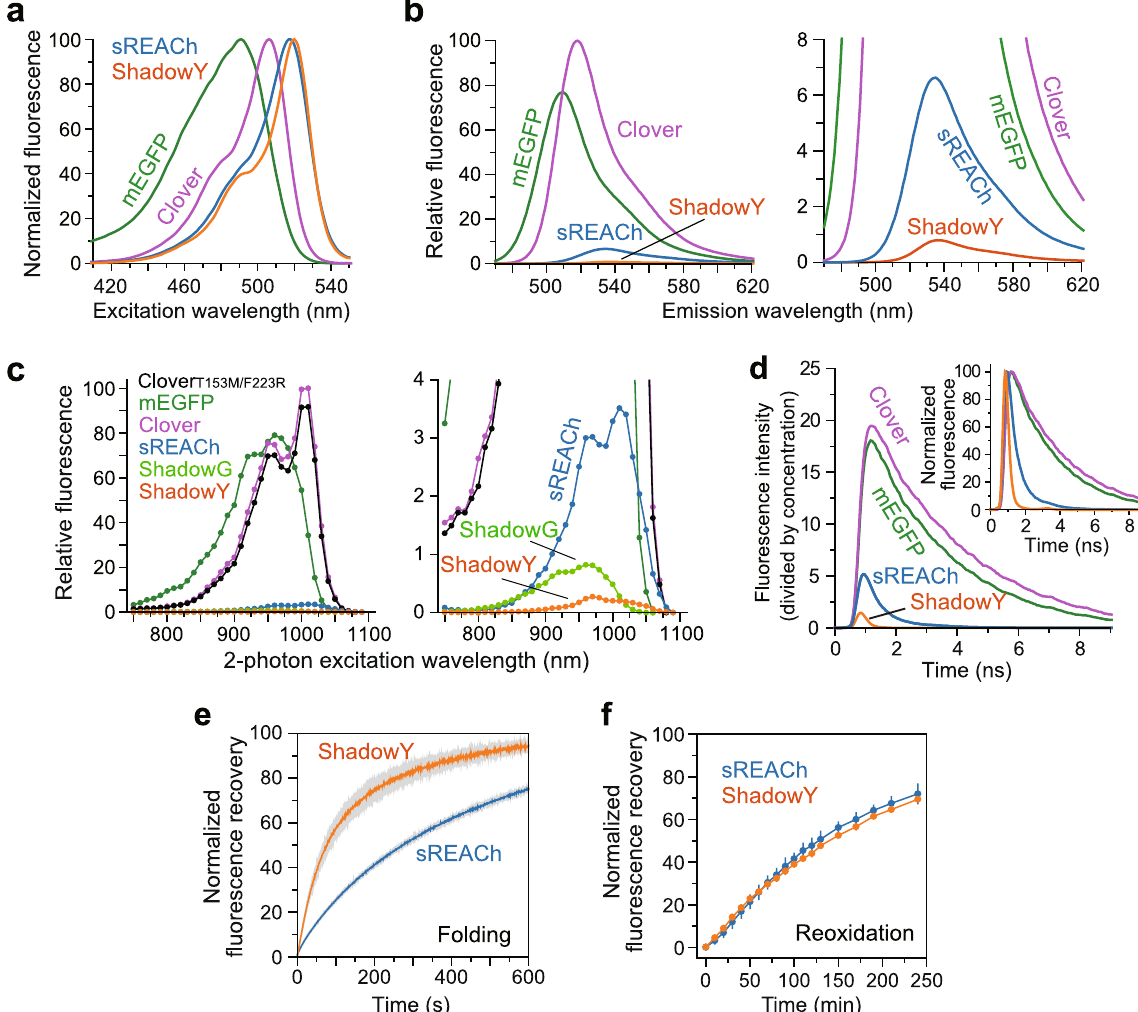
Figure 2. Spectrofluorimetric analysis of purified ShadowY. ( a ) Normalized excitation spectra of mEGFP, Clover, sREACh, and ShadowY. ( b ) The emission spectra of mEGFP, Clover, sREACh, and ShadowY excited at 450 nm. For all the samples, optical density at 450 nm is adjusted to the same value. (right) An enlarged view of left panel. ( c ) Two-photon excitation spectra of 5 µ M mEGFP, 5 µ M Clover, 5 µ M Clover T153MF223R , 30 µ M sREACh, 100 µ M ShadowG, 100 µ M ShadowY. The measured fluorescence intensities were divided by the respective protein concentrations, and the peak intensity of Clover was normalized to 100. (right) An enlarged view of left panel. ( d ) Fluorescence lifetime curves of the fluorescent proteins subjected to 2-photon excitation at 920 nm. Measured fluorescence intensity was divided by the respective protein concentration. (inset) Normalized fluorescence lifetime curves. ( e , f ) Fluorescence recovery of sREACh and ShadowY from a denatured ( e ) or reduced state ( f ). The respective fluorescent protein was excited at 517 nm with 5 nm bandwidth, and its fluorescence recovery was monitored at 531 nm with 5 nm bandwidth. Three independent experiments were averaged (the data are shown as mean ±